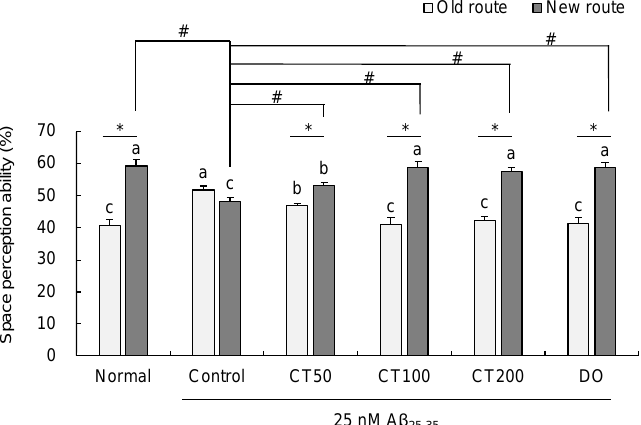
Figure 3. Effect of combination with Carthamus tinctorius L. seed and Taraxacum coreanum (CT) on T- maze test. Values are mean ± SD. a–c Means indicated with different letters are significantly different by Duncan’s multiple range test; * p < 0.05 vs. old route, # p < 0.05 vs. control group. Normal: 0.9% NaCl + water; Control: Aβ 25-35 + water; CT50: Aβ 25-35 + CT (50 mg/kg/day); CT100: Aβ 25-35 + CT (100 mg/kg/day); CT200: Aβ 25-35 + CT (200 mg/kg/day); DO: Aβ 25-35 + donepezil (5 mg/kg/day).